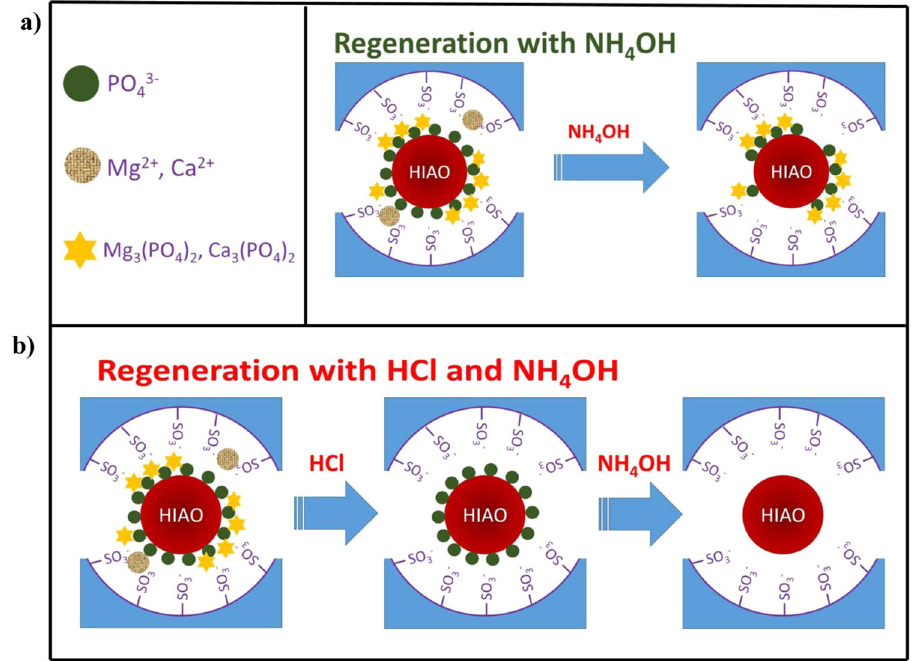
Fig. 7 Mechanism for the regeneration of HIAO/225H material. a The material after the adsorption process was regenerated with NH 4 OH solution. b The material after the adsorption process was regenerated with HCl and NH 4 OH